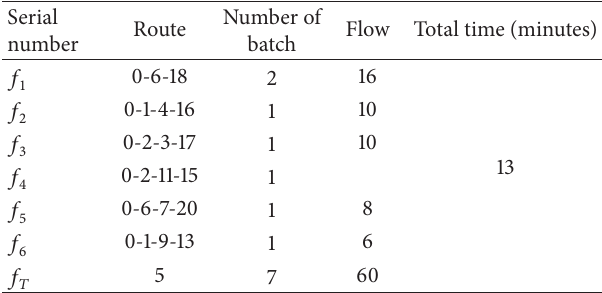
Table 8: Optimal routes of one-to-many evacuations on